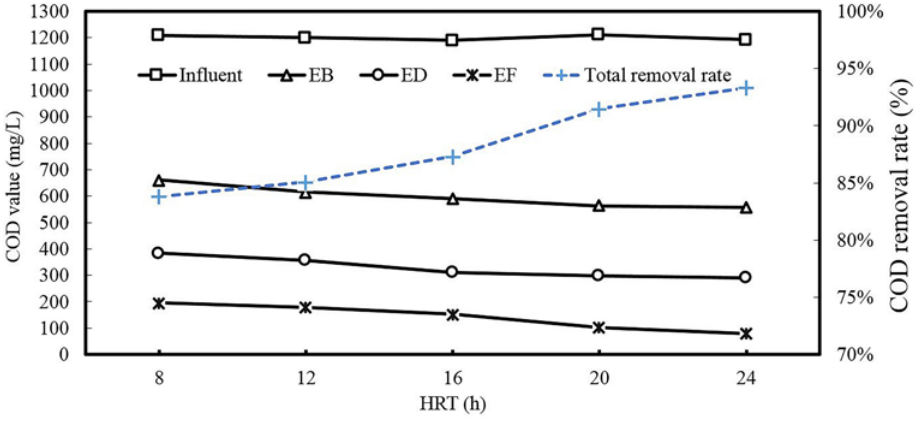
Figure 4. Variations in COD concentration and total removal rate at different HRTs.